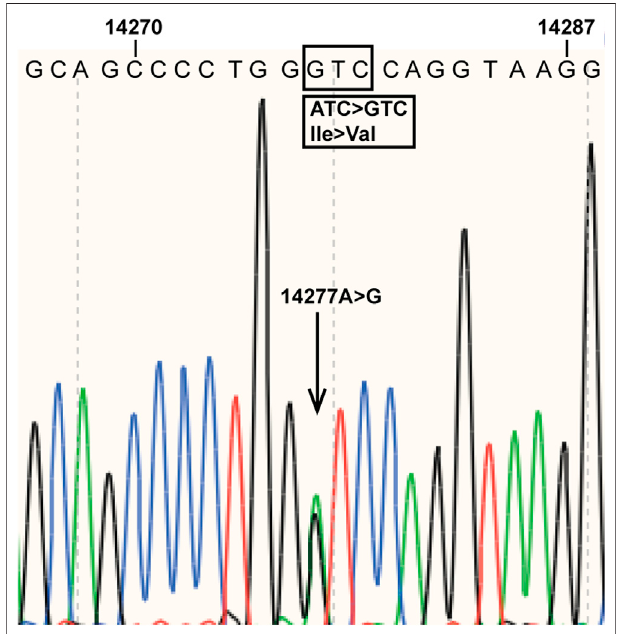
FIGURE 1 | Novel mutation in CYP2C9 exon 4. The arrow indicates the mutation detected at nucleotide position 14,277 of the reference sequence (NG_008385.2). The boxes show the mutation and the amino acid substitution (I213V) caused by the mutation.